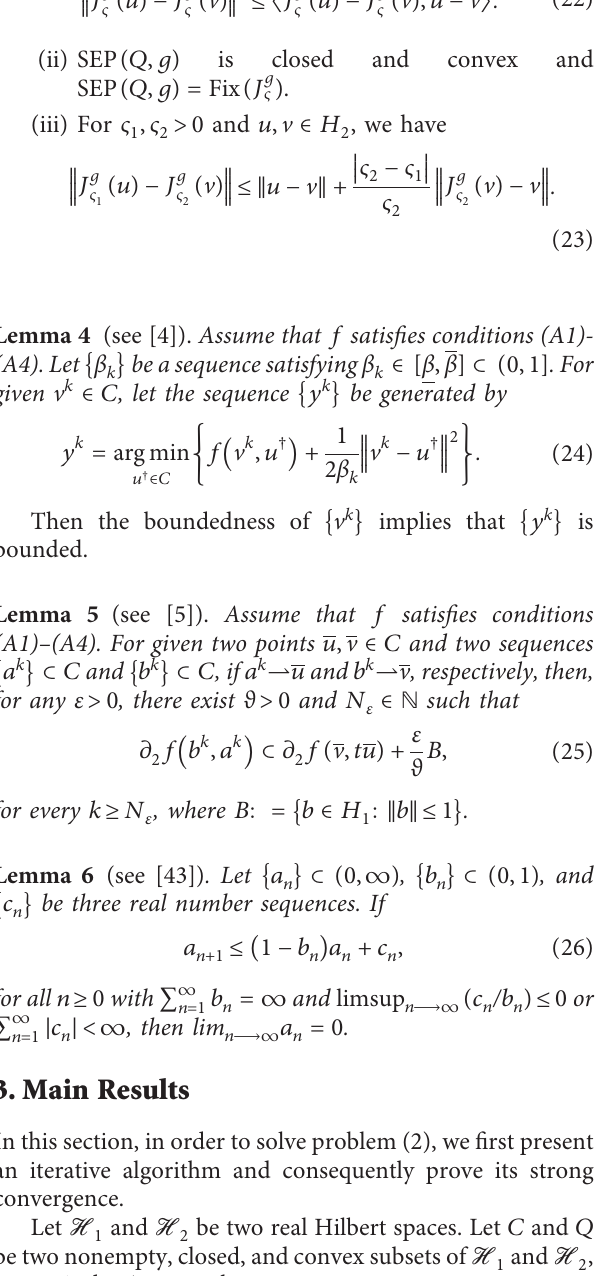
Algorithm 1. Fix an initial point x 0 ∈ C . Set k �